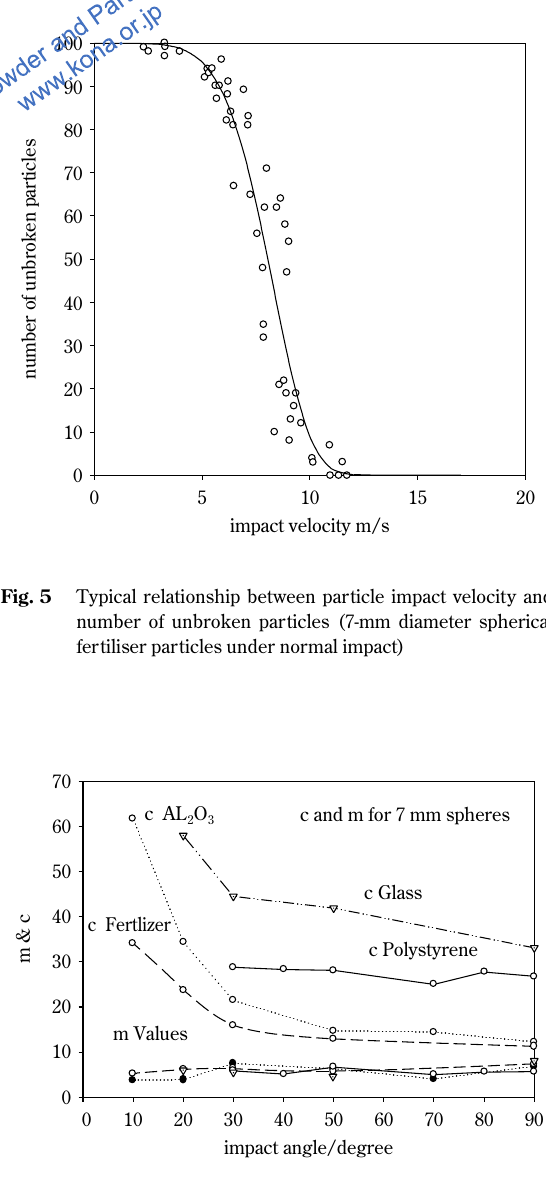
Fig. 6 Weibull distribution parameters for 7-mm spheres from a range of